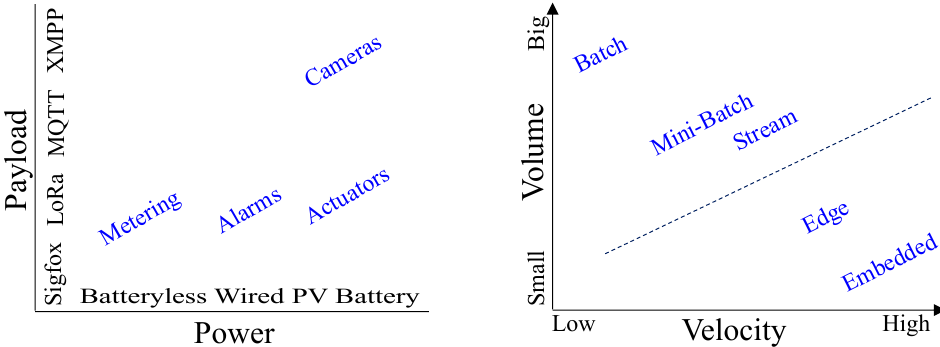
Figure 8. Device and cloud solutions in technological